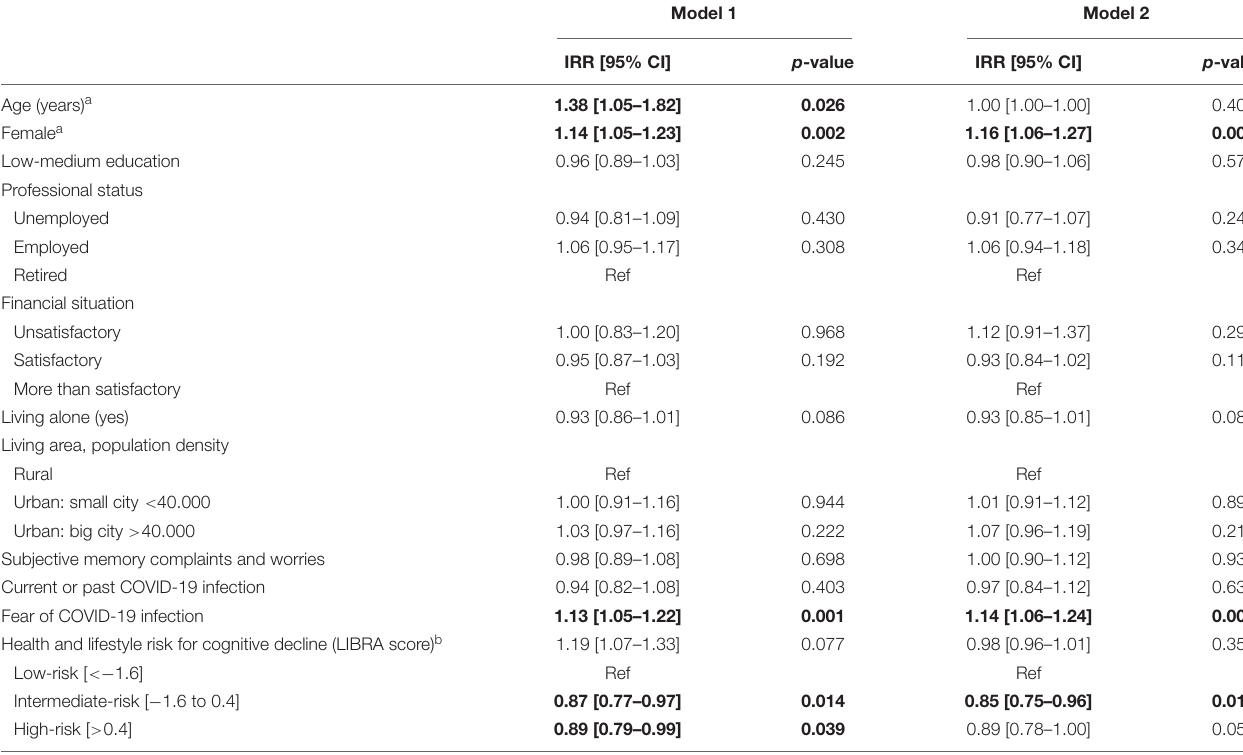
TABLE 3 | Univariable and multivariable analyses of the association of participant characteristics with multiple beneficial lifestyle